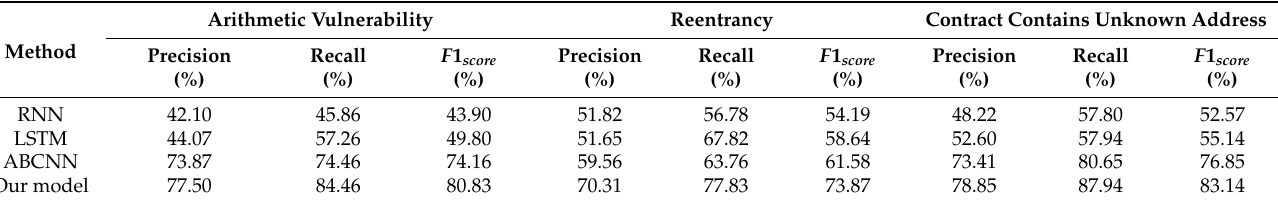
Table 9. Comparative experimental results of ML